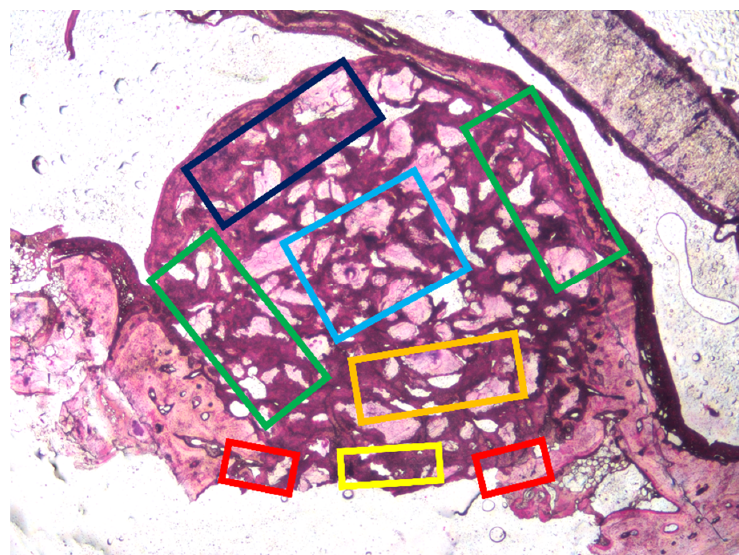
Figure 2. Regions evaluated within the augmented sinuses: (I) close to the bone walls (green rectangle), (II) center of the augmented region (light blue rectangle), (III) subjacent to the sinus mucosa (dark blue rectangle), (IV) and close to the osteotomy region (orange rectangle). Regions evaluated at the osteotomy site: (V) adjacent to the edges (red rectangles) and (VI) the center (yellow rectangle).